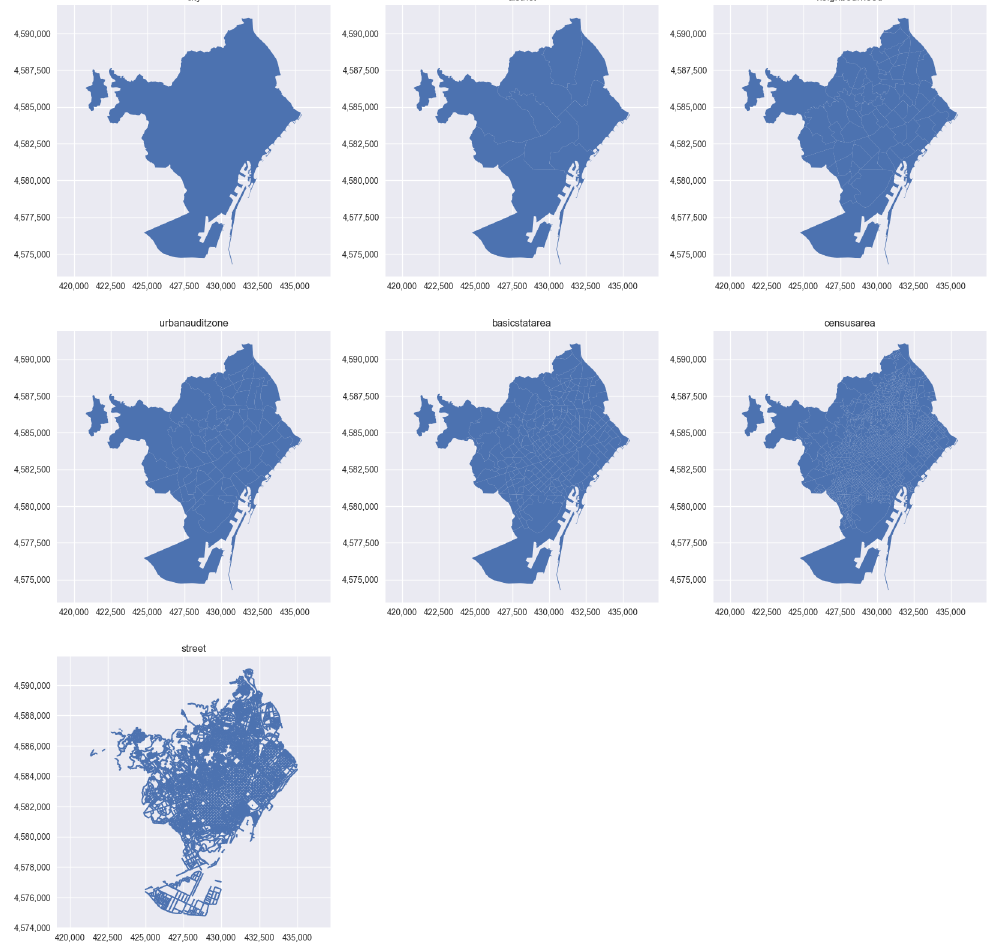
Figure 4. Geographic sections defined for Barcelona